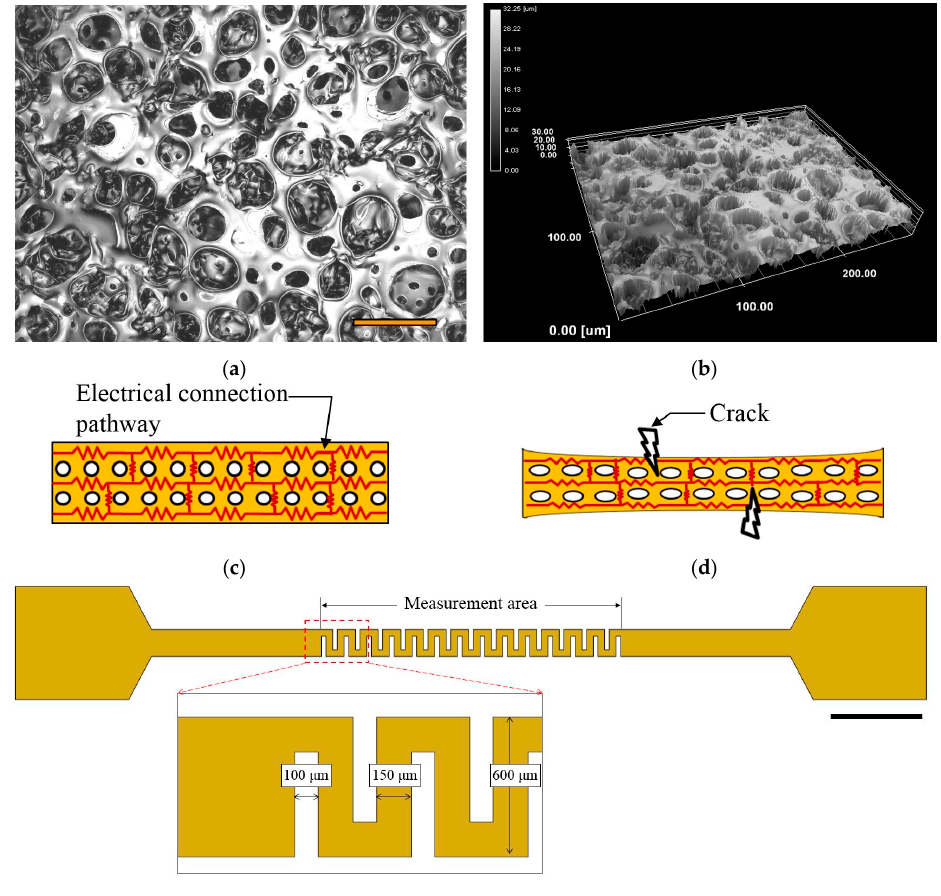
Figure 2. ( a ) Laser microscopic image of the second PDMS layer. Scale bar marks 50 μ m. ( b ) 3D